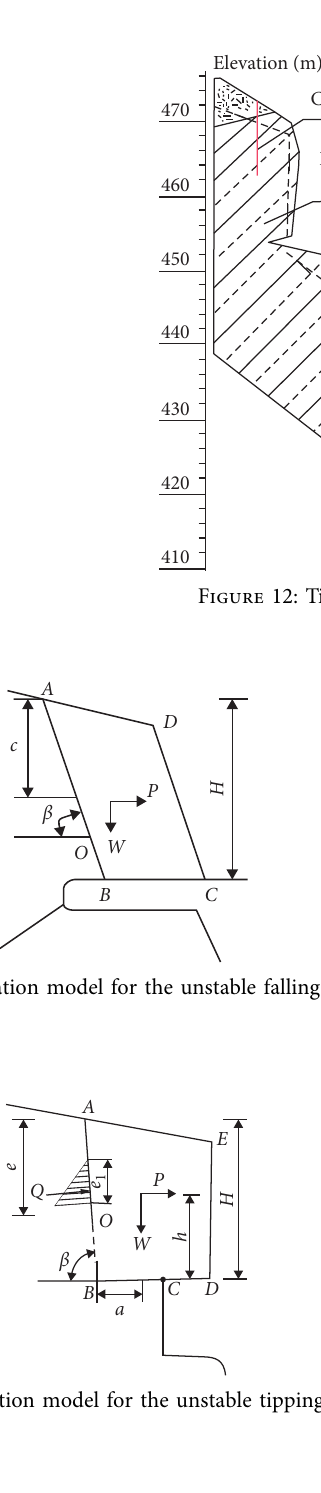
Table 3: Suggested parameter values.